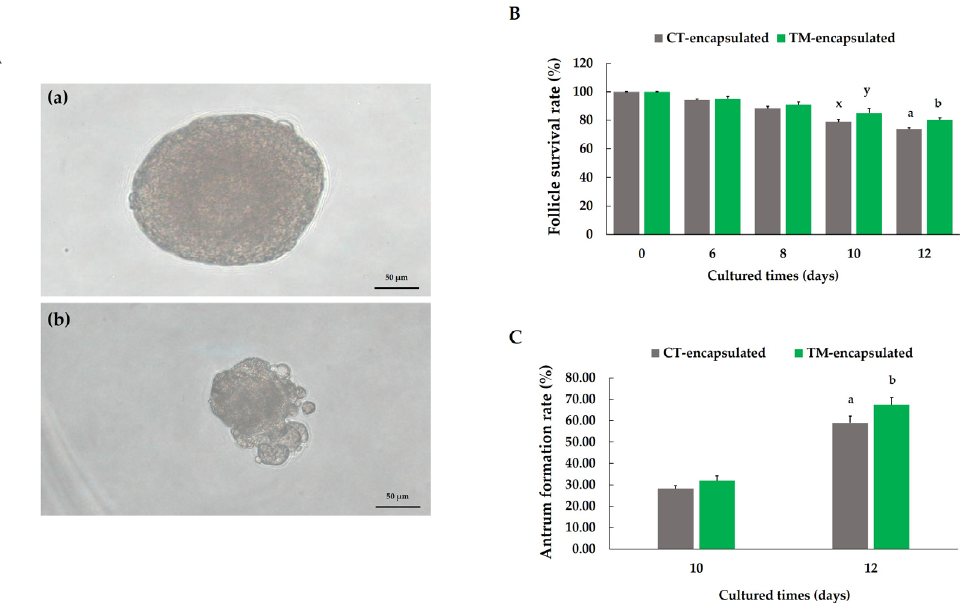
Figure 3. Effect of culture medium on mouse follicle growth. ( A ) Representative images of follicles without antrum formation at the end of culture period (a) and degenerated follicle (b). Scale bar: 50 µm. ( B ) Follicle survival rate. ( C ) Antrum formation rate on days 10 and 12. Different letters (a,b) indicate significant differences at p < 0.05, while different superscripts (x,y) tend to differ at 0.05 < p ≤ 0.10 in effects between two groups of follicles. Comparison between groups was performed using chi-squared test. n = 500 preantral follicles (grey bars) and n = 498 preantral follicles (green bars) for ten replications.